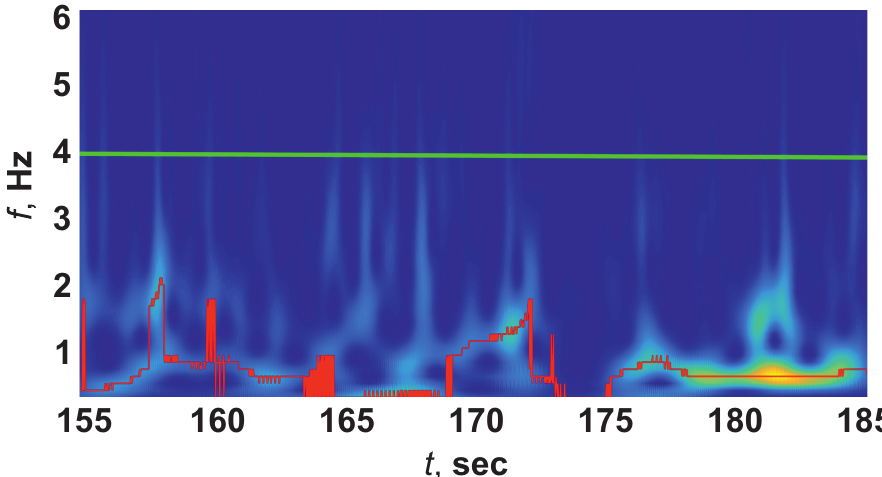
Figure 9. Wavelet spectrogram of an EEG with chewing artifact. Green line corresponds to slice of the wavelet spectrogram at the frequency f cur = 4 Hz.